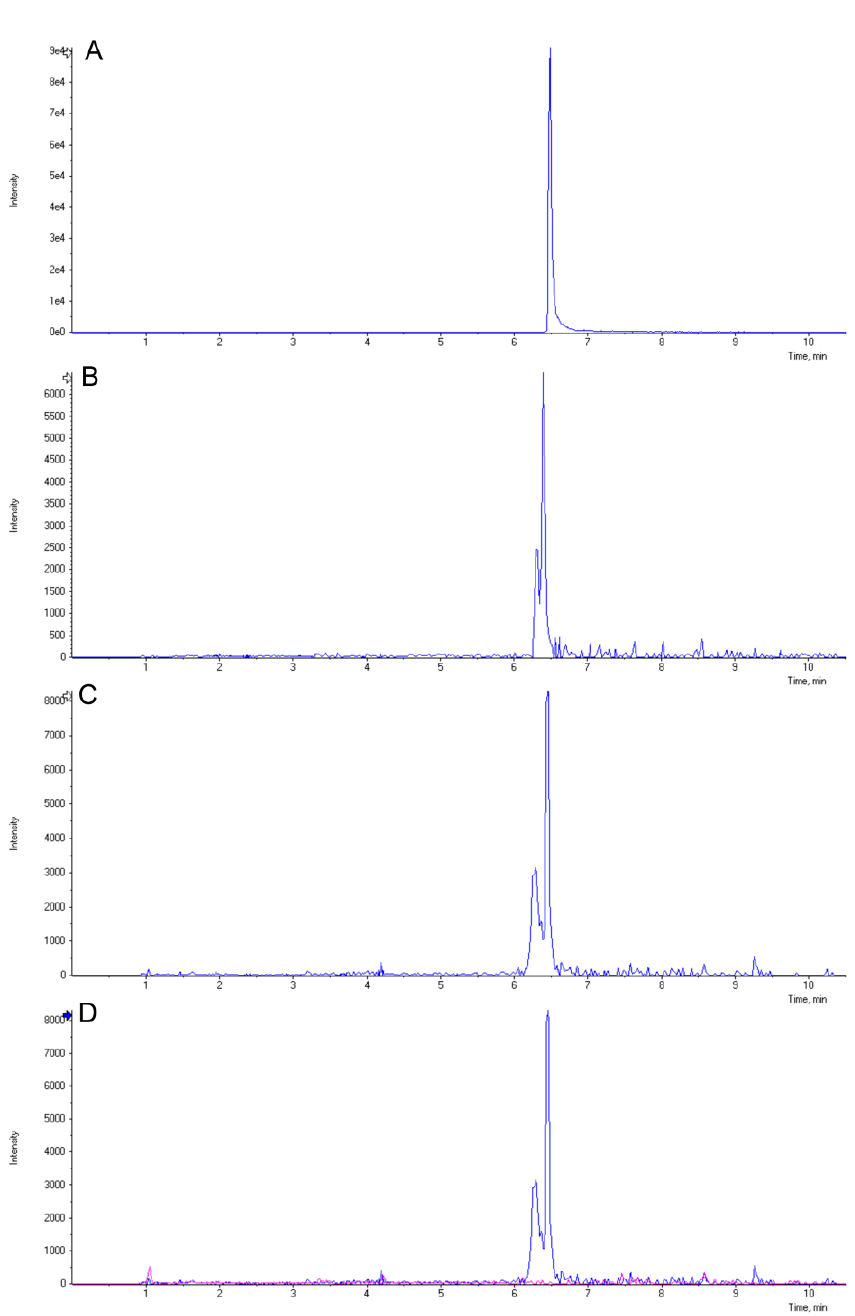
Figure 5. Induction of 3-deoxyanthocyanidins and their derivatives in Y1- maize. LC-MS chromatograms obtained from the luteolinidin standard ( A ), infected leaves of Y1-rr (( B , C ) representing two biological replicates), and an overlay ( D ) of Y1-rr (sample B; blue trace) and NS (pink trace) are presented for comparison. The m / z values of the extracted chromatograms were similar to those of the luteolinidin standard